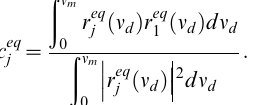
Figure 2. Gain modulation in the steady state. (A) The response curve r eq n d ð Þ for different levels of balanced background activity ( n 0 is specified, see Equation (4)). For high output firing determined once n 0 i rates outside of the boxed region, the slopes of all of the response curves are almost equal. (B) Top Panel: zoomed region of (A). Bottom Panel: a least squares fit was used to find the scalar c eq (11)), and we plot the scaled response c eq ~ 3 : 2 . c eq 3